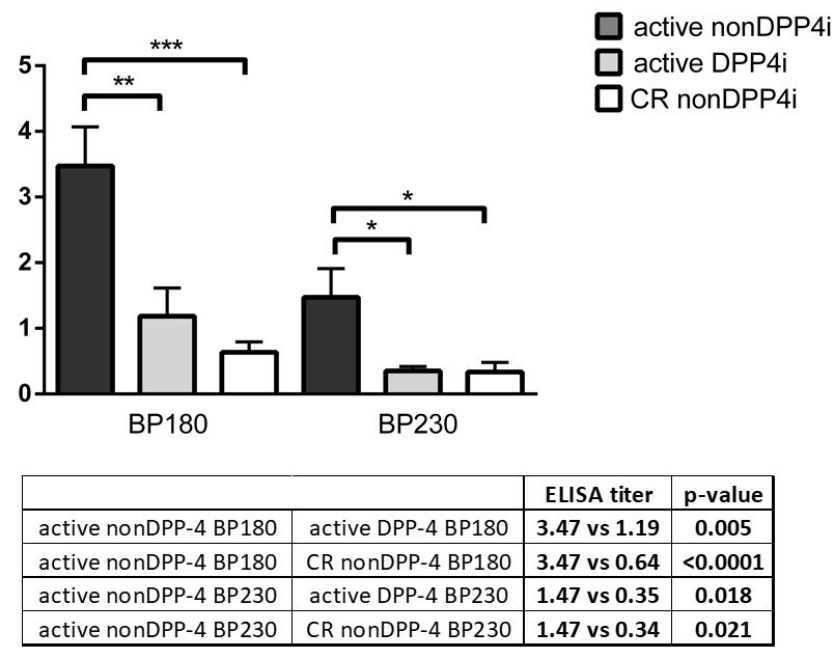
Figure 5. BP180 and BP230 ELISA titers of untreated DPP4i (active DPP4i), untreated nonDPP4i BP (active nonDPP4i) and treated nonDPP4i with complete response (CR nonDPP4i) BP patients; (* p < 0.05; ** p ≤ 0.01; *** p ≤